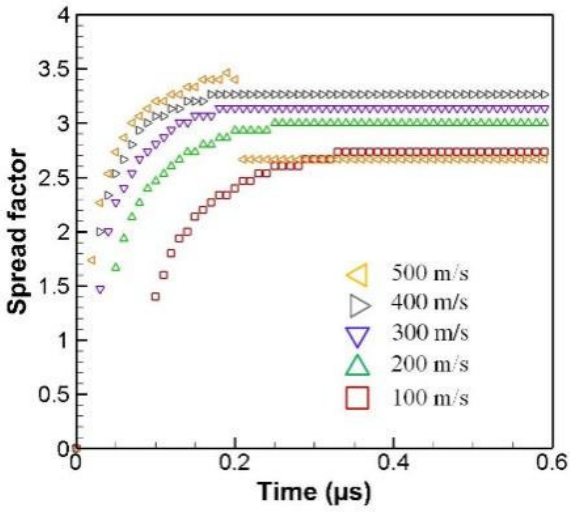
Figure 12. Spread factor evolution for YSZ drop at different velocities.